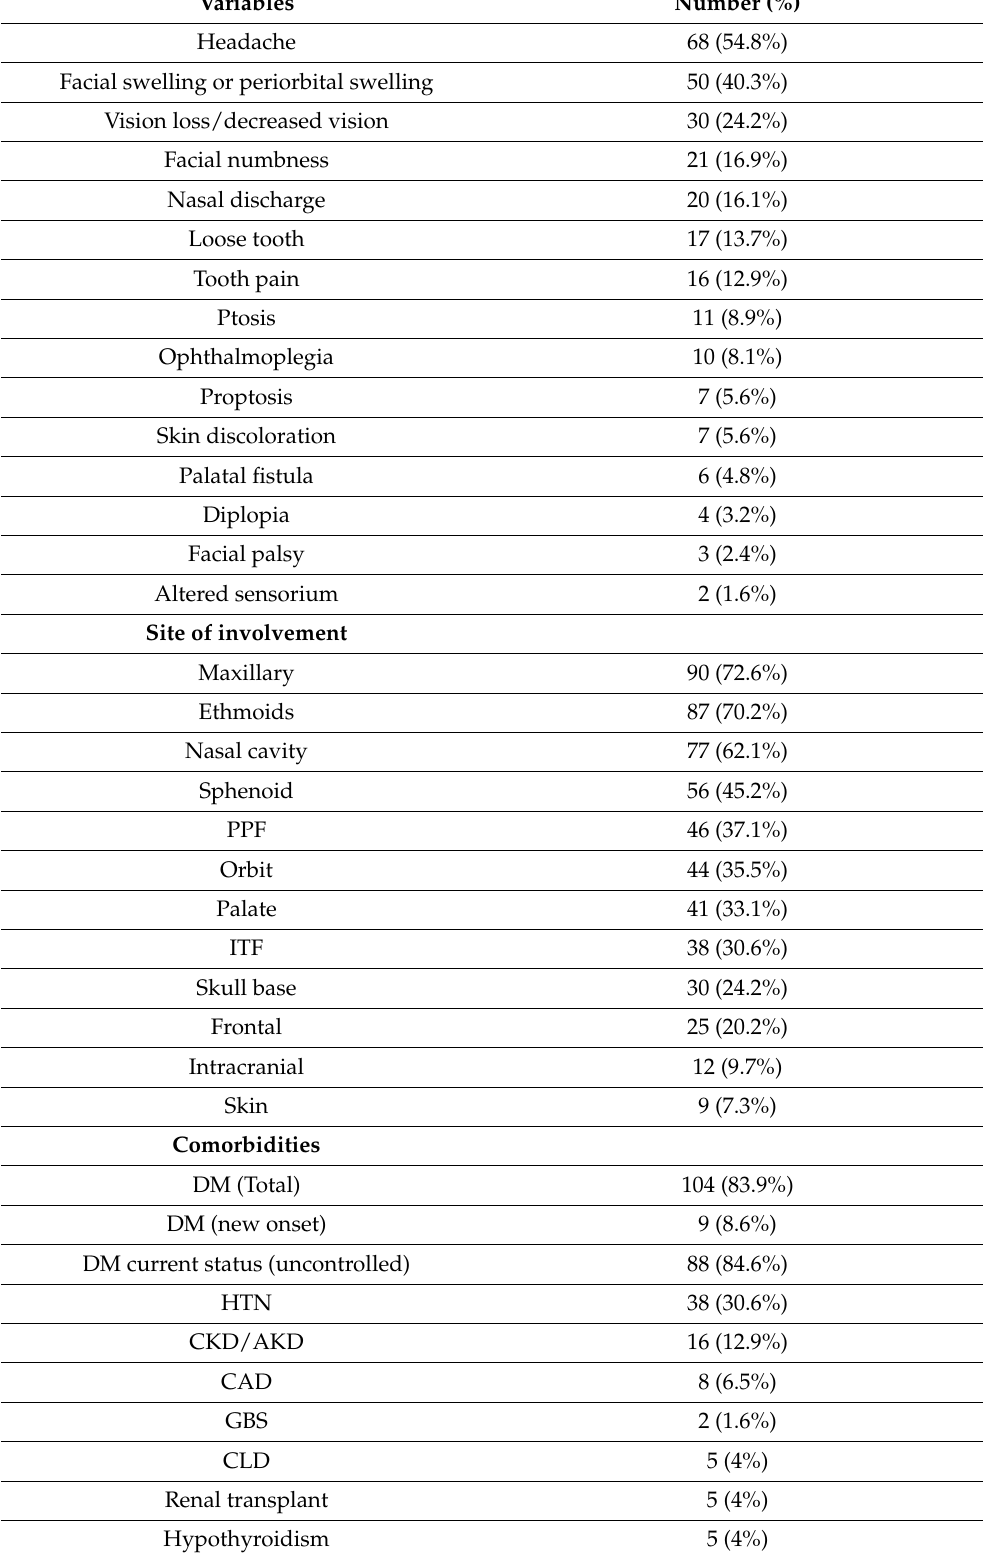
Table 2. Clinical symptoms, site, and comorbidities among COVID-19 patients (N =